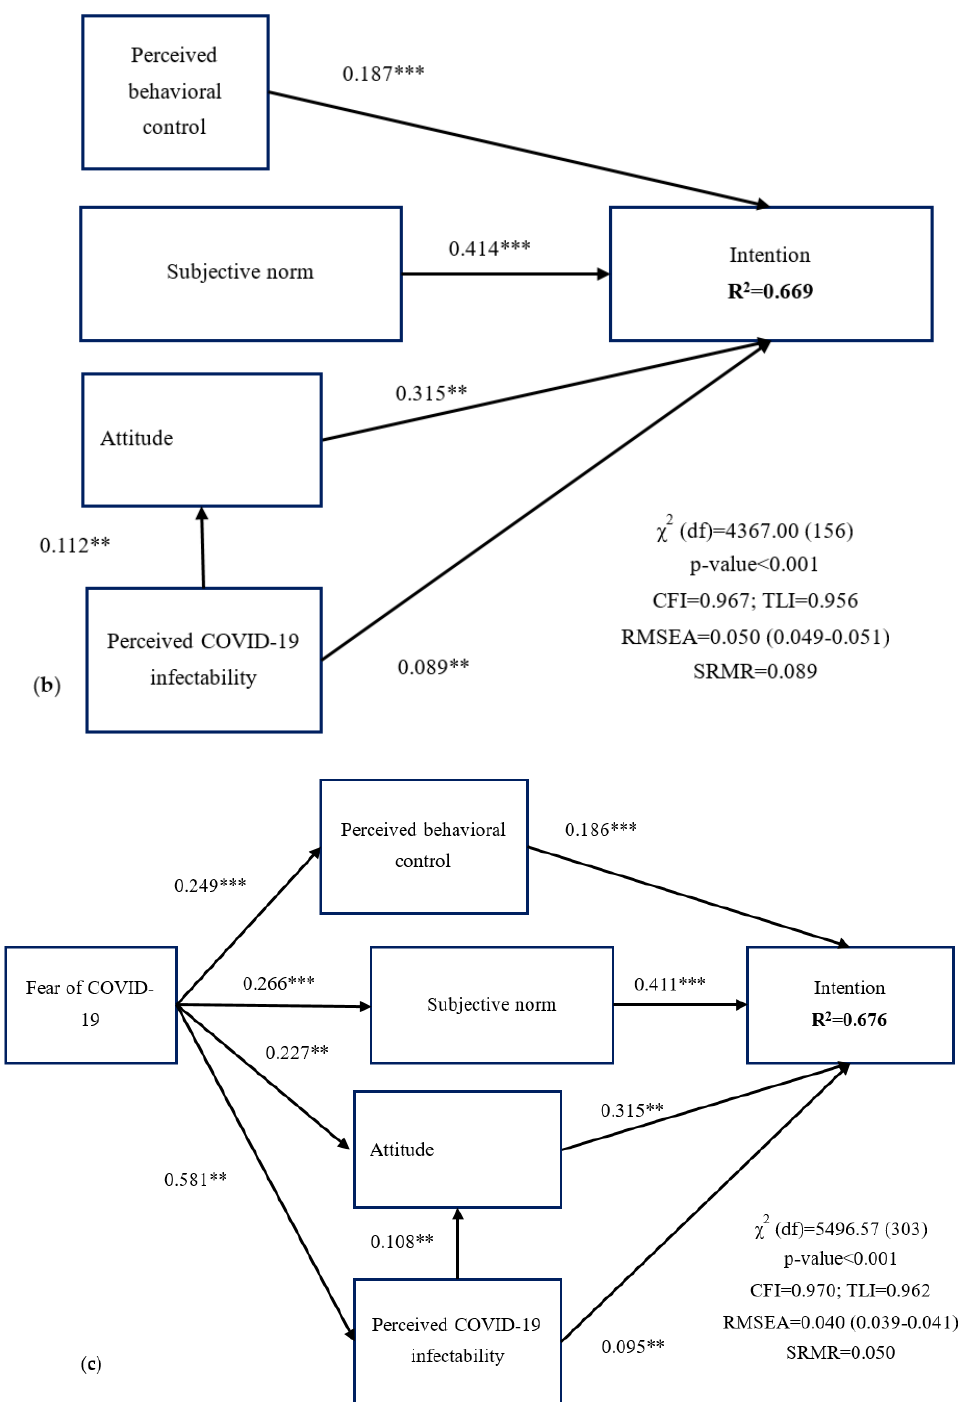
Figure 2. ( a ) Findings in the proposed model without perceived COVID-19 infectability and fear of COVID-19; ( b ) Findings in the proposed model without fear of COVID-19; ( c ) Findings in the proposed model; all the constructs together explained 67.6% of the intention to get COVID-19 vaccinated. Perceived behavioral control, subjective norm, attitude, and intention are constructs described in Theory of Planned Behavior; fear of COVID-19 and perceived COVID-19 infectability are constructs described in Protection Motivation Theory. ** p < 0.01; *** p < 0.001; CFI = comparative fit index; TLI = Tucker-Lewis index; RMSEA = root mean square error of approximation; SRMR = standardized root-mean-square